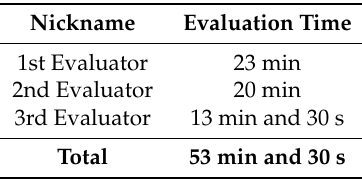
Table 12. Evaluation time